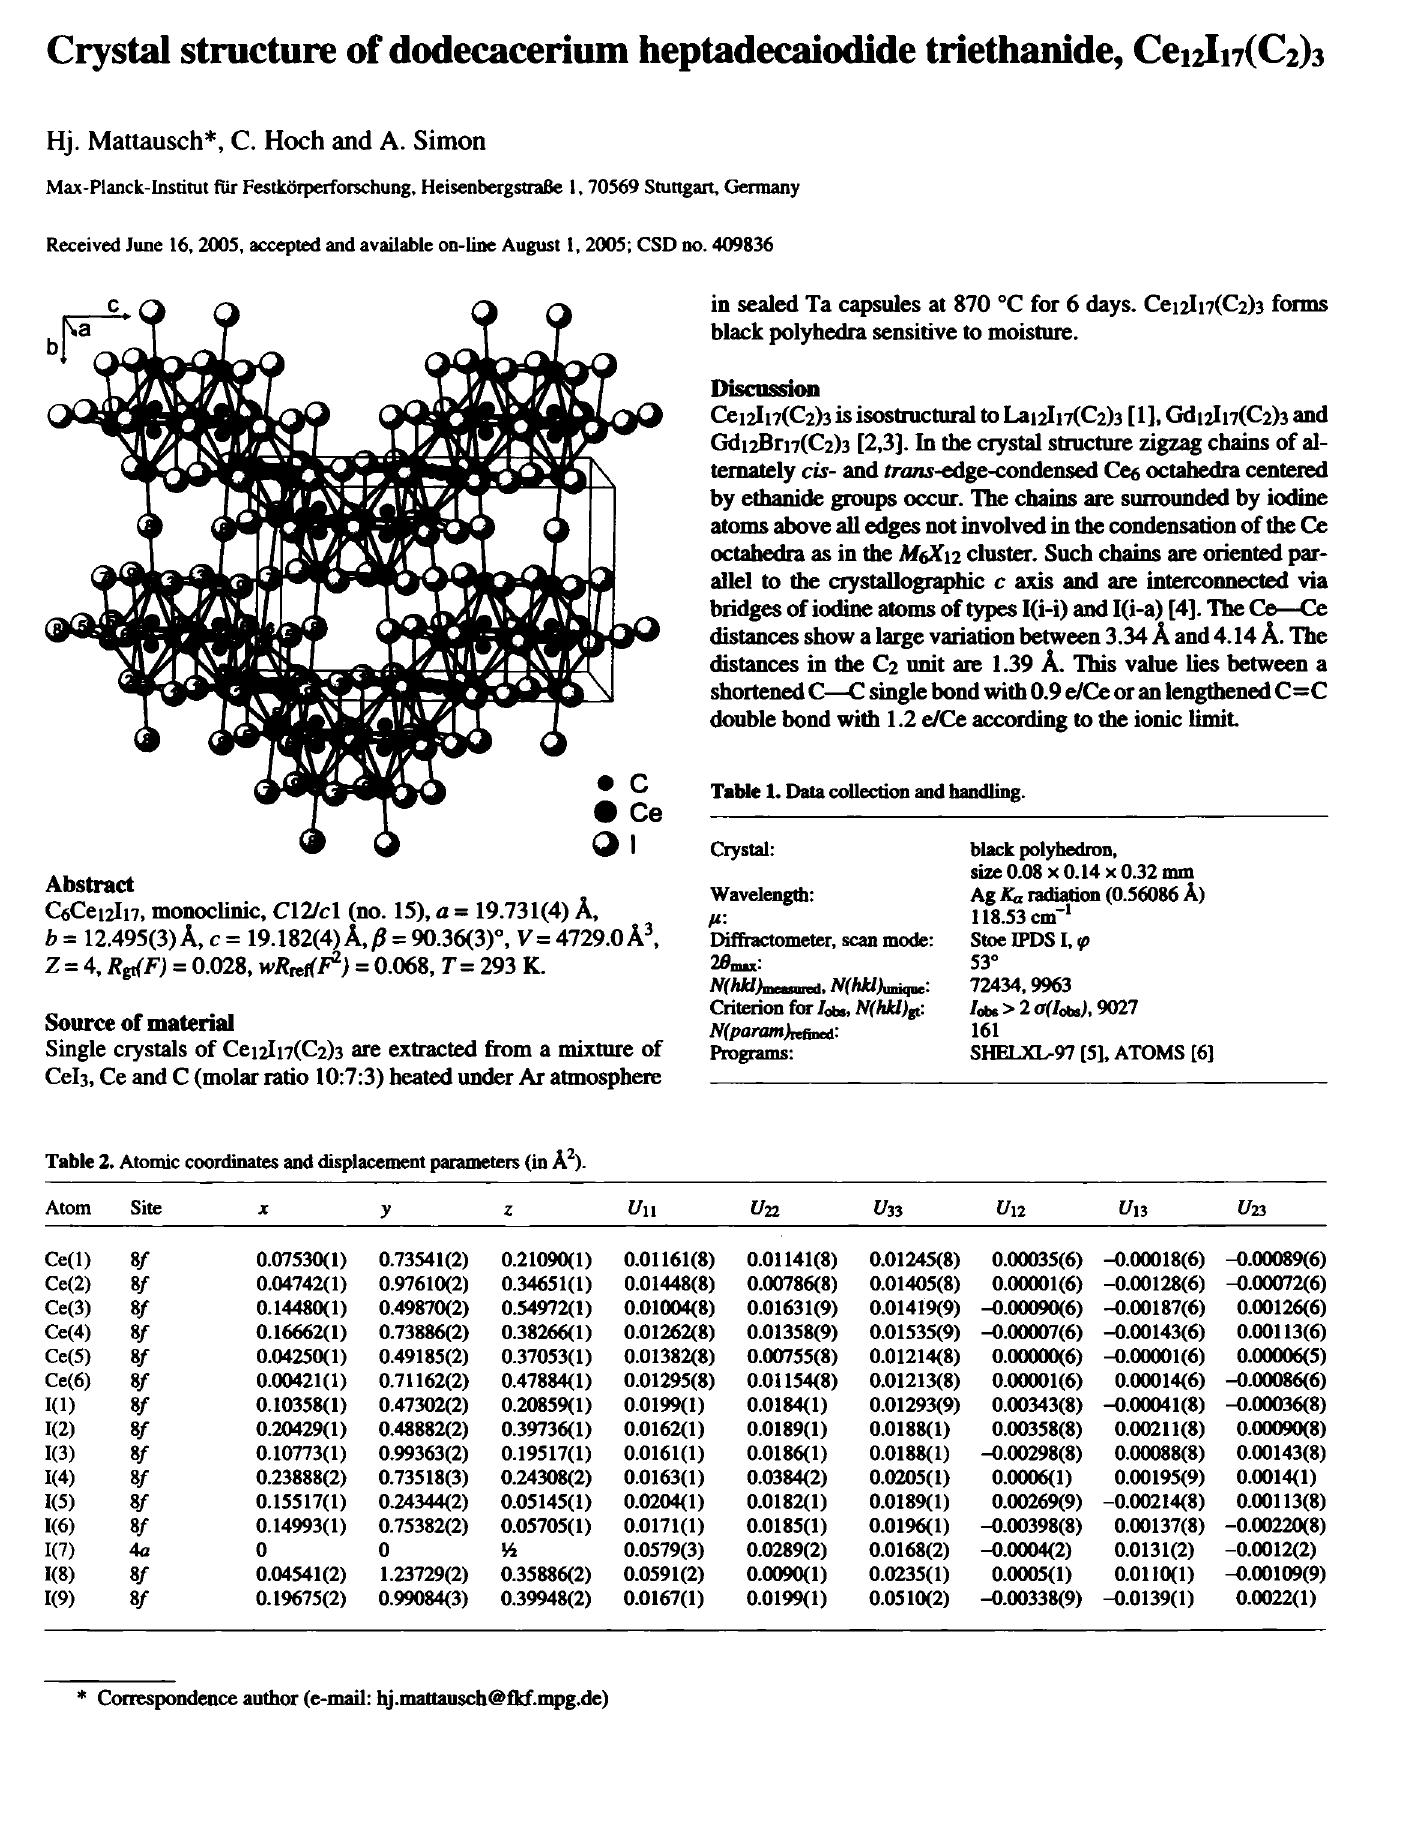
Table 1. Data collection and handling.